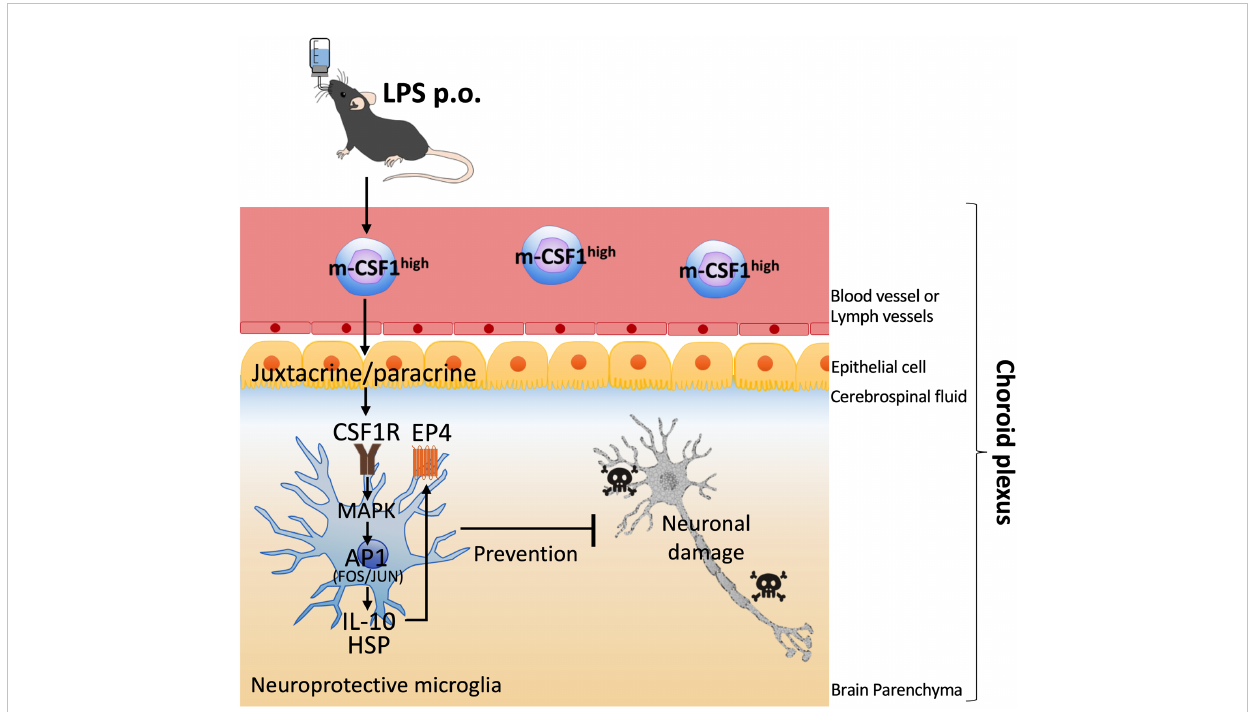
FIGURE 1 Hypothetical mechanism of induction of neuroprotective microglia by OAL. OAL promotes m-CSF1 expression on peripheral leukocytes. In the physiological state, peripheral leukocytes communicate with healthy CNS cells in the choroid plexus for homeostasis maintenance. In pathological conditions, the microglial CSF1R activation by m-CSF1 on peripheral leukocytes induces transformation to neuroprotective microglia, which contributes to the prevention of dementia. OAL, oral administration of LPS; m-CSF1, membranous colony stimulating factor 1; CNS, central nervous system; CSF1R, CSF1